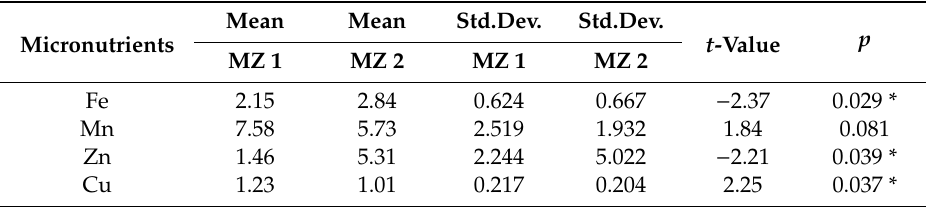
Table 3. Student’s t -test for mean values of micronutrients present in management zone 1(MZ1) and 2